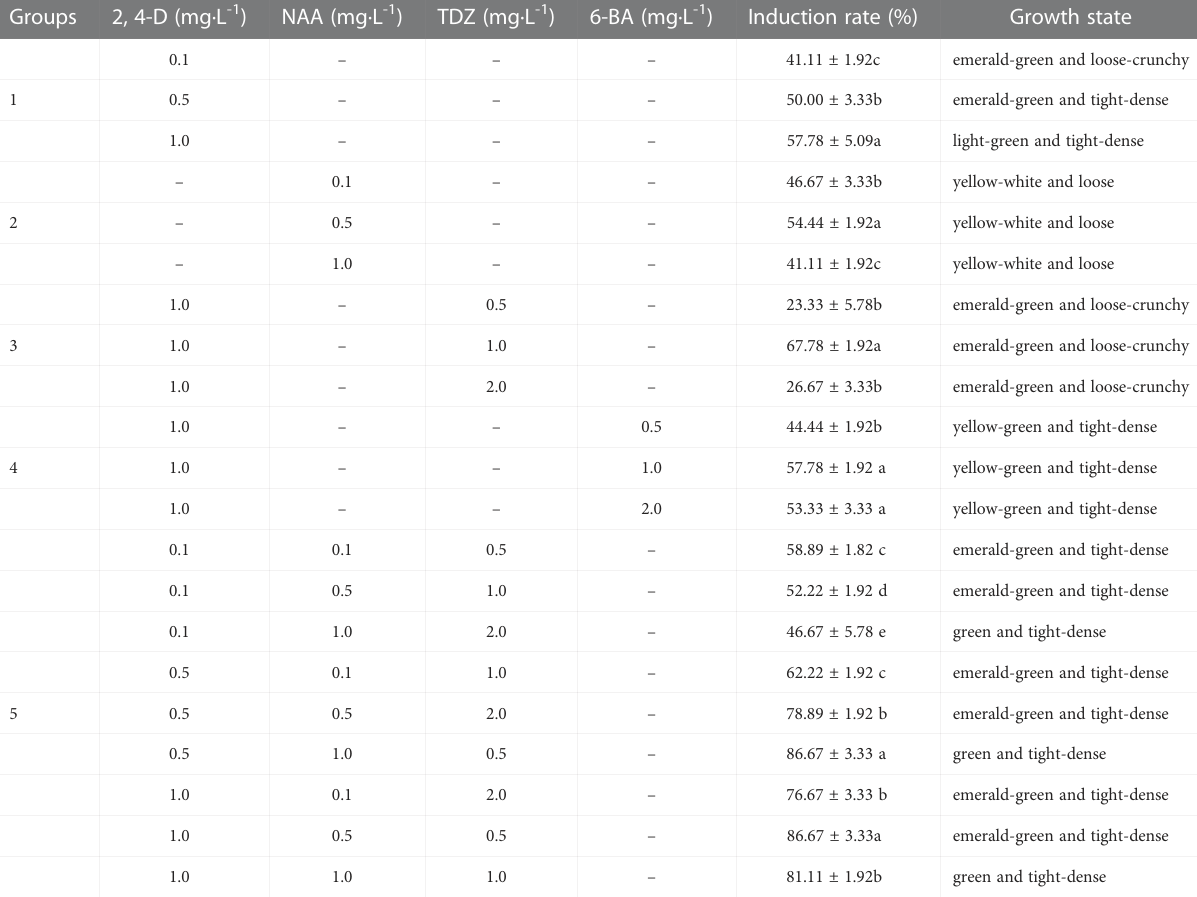
TABLE 1 Effect of 2.4-D (mg·L -1 ), NAA, TDZ and 6-BA on P. lacti fl ora callus induction.